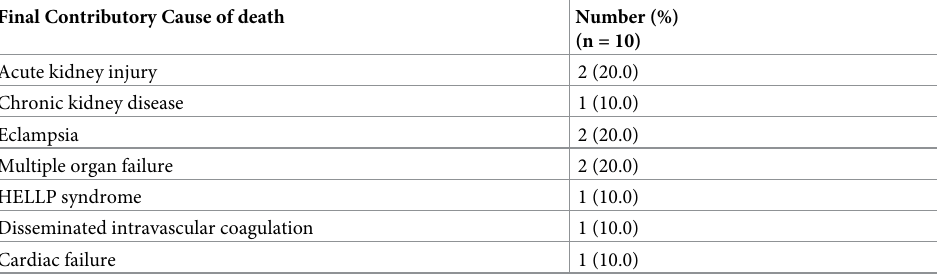
Table 3. Final contributory causes of maternal